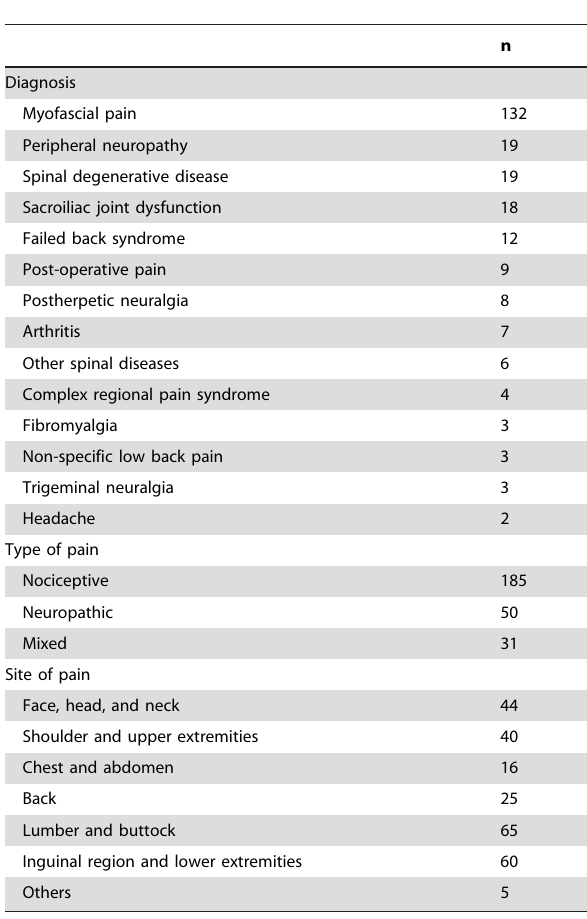
Table 4. Characteristics of pain